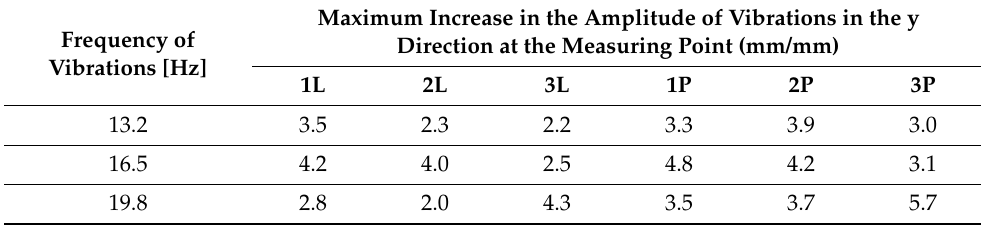
Table 4. Maximum multiples of vibration amplitude values in the y direction.